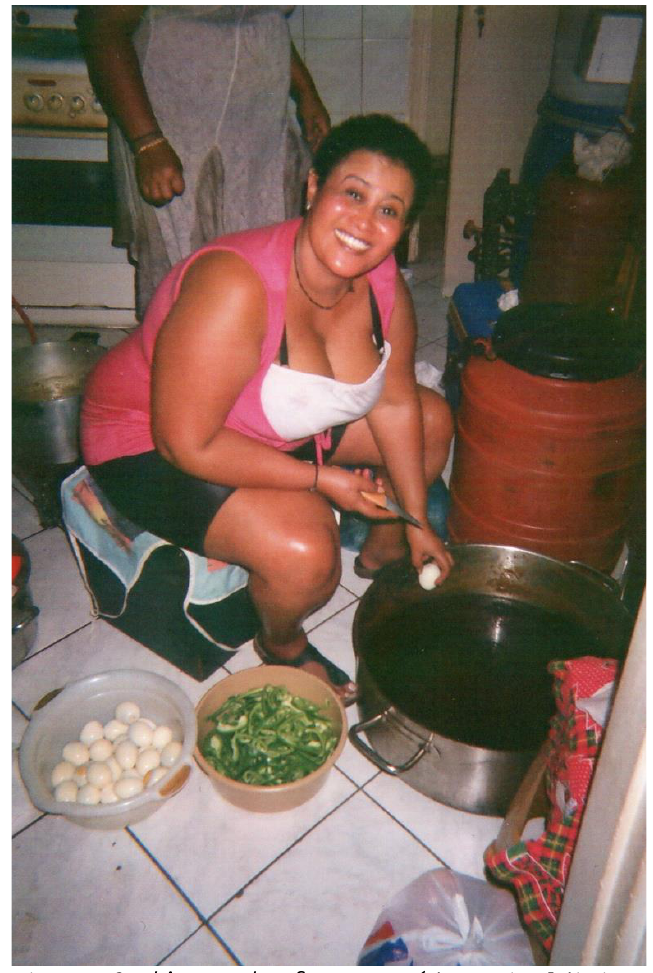
Figure 4: Cooking together for an event (photo: visual diaries